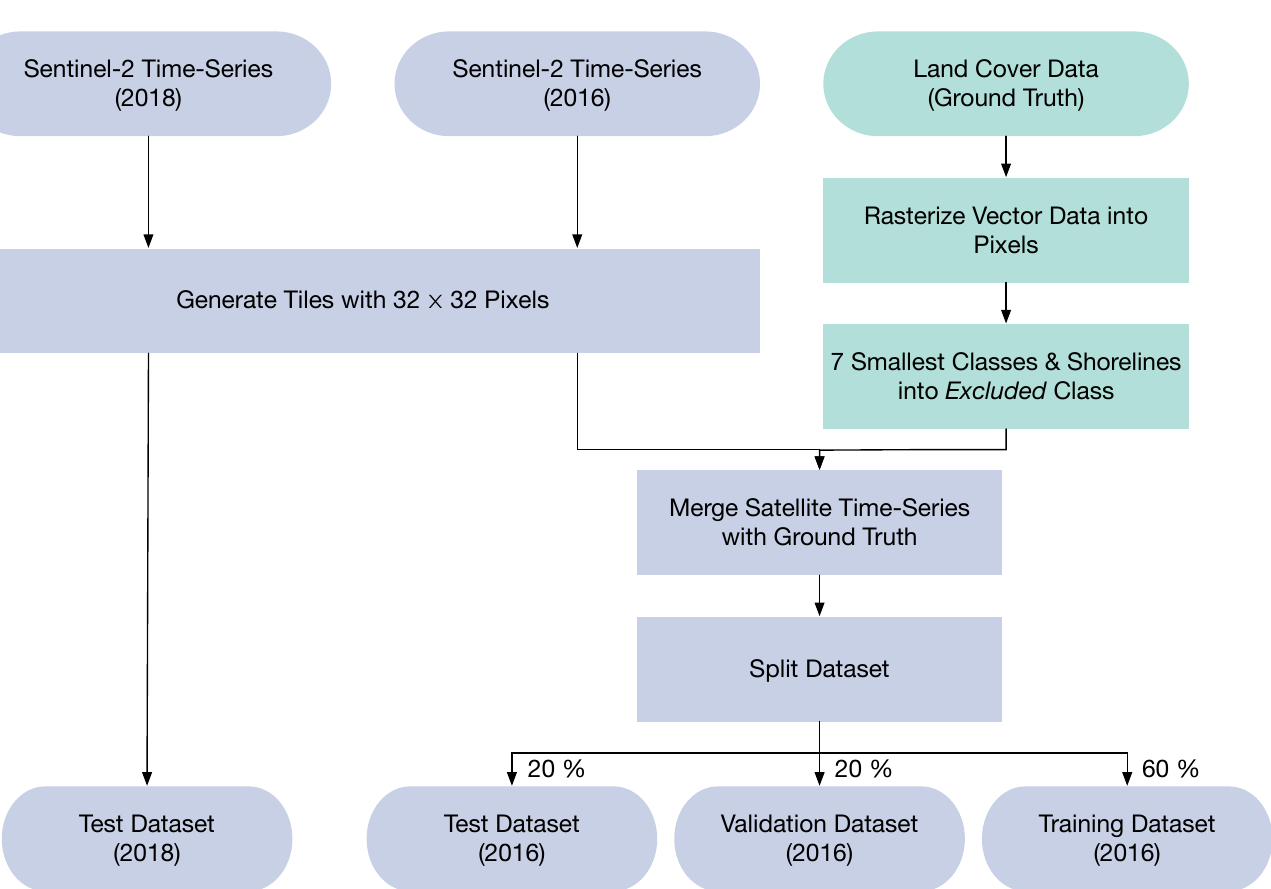
Figure 2. Pre-processing schema for the Sentinel-2 satellite imagery (blue) and the land cover ground truth (GT)